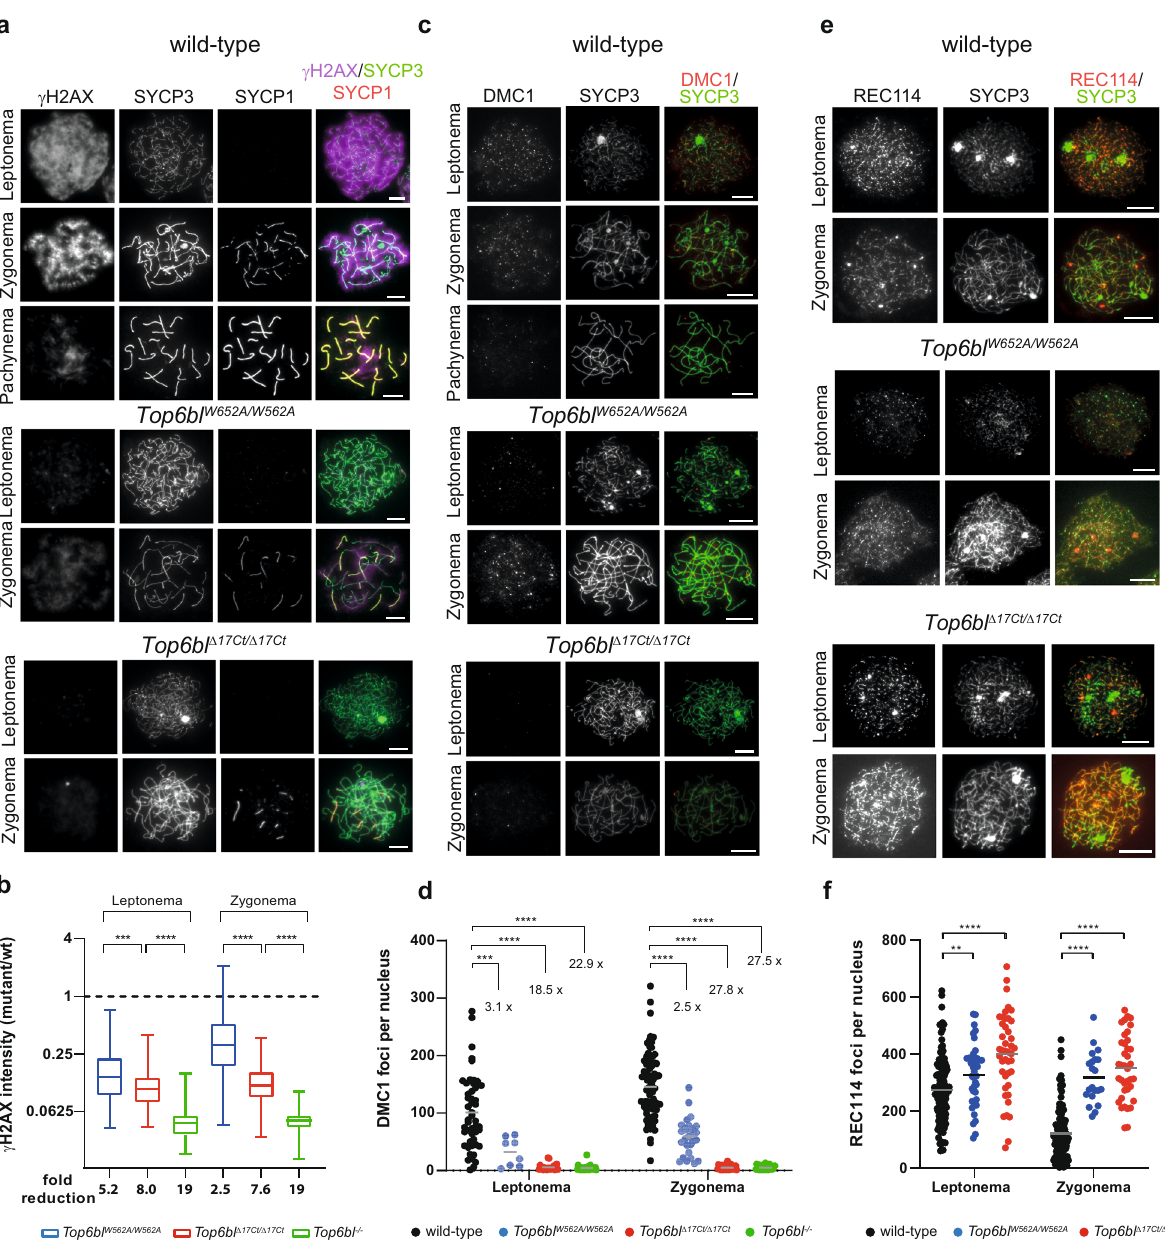
Fig. 3 | In Top6bl W562A/W562A and Top6bl Δ 17Ct/ Δ 17Ct mice, meiotic DSB activity is decreased in oocytes. a Immunostaining of γ H2AX, SYCP3 and SYCP1 in oocytes from 16 dpc wild-type (+/+), Top6bl W562A/W562A , and Top6bl Δ 17Ct/ Δ 17Ct ovaries. Scale bar, 10 μ m. b Quanti fi cation of γ H2AX signal intensity in leptotene and zygotene (or zygotene-like) nuclei of oocytes from 16 dpc wild-type (+/+ or Top6bl +/ Δ 17Ct ), Top6bl W562A/W562A , Top6bl Δ 17Ct/ Δ 17Ct , and Tob6bl -/- mice ( n =5, 2, 2, and 1 mouse/geno- type). Number of nuclei at leptonema: 126, 123, 73, and 23; number of nuclei at zygonema:241,132,64,and33foreachgenotype.Ratiosoftheintegratedintensity between the mean values in mutant nuclei and in wild-typenuclei are plotted (box plot as de fi ned in Methods). P values were determined using the two-tailed unpaired Mann-Whitney test. The fold reduction is the ratio of the wild-type to mutantmeanvalues. c ImmunostainingofDMC1andSYCP3inoocytesfrom16dpc or 17 dpc wild-type (+/+), Top6bl W562A/W562A and Top6bl Δ 17Ct/ Δ 17Ct ovaries. Scale bar, 10 μ m. d Quanti fi cation of DMC1 foci. DMC1 axis-associated foci were counted in